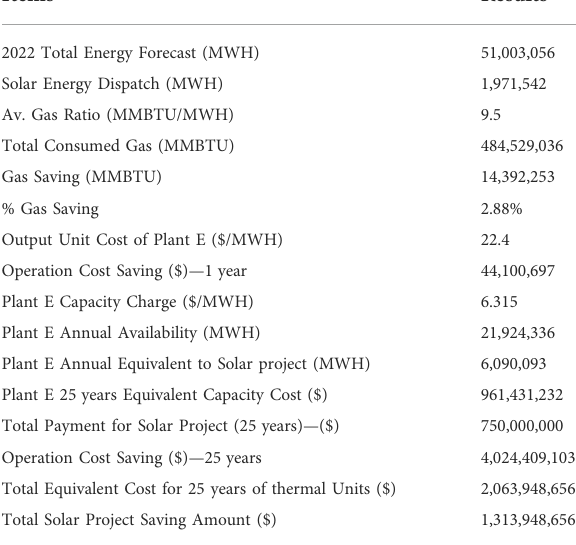
TABLE 5 Financial comparison between PV solar operation and thermal operation.